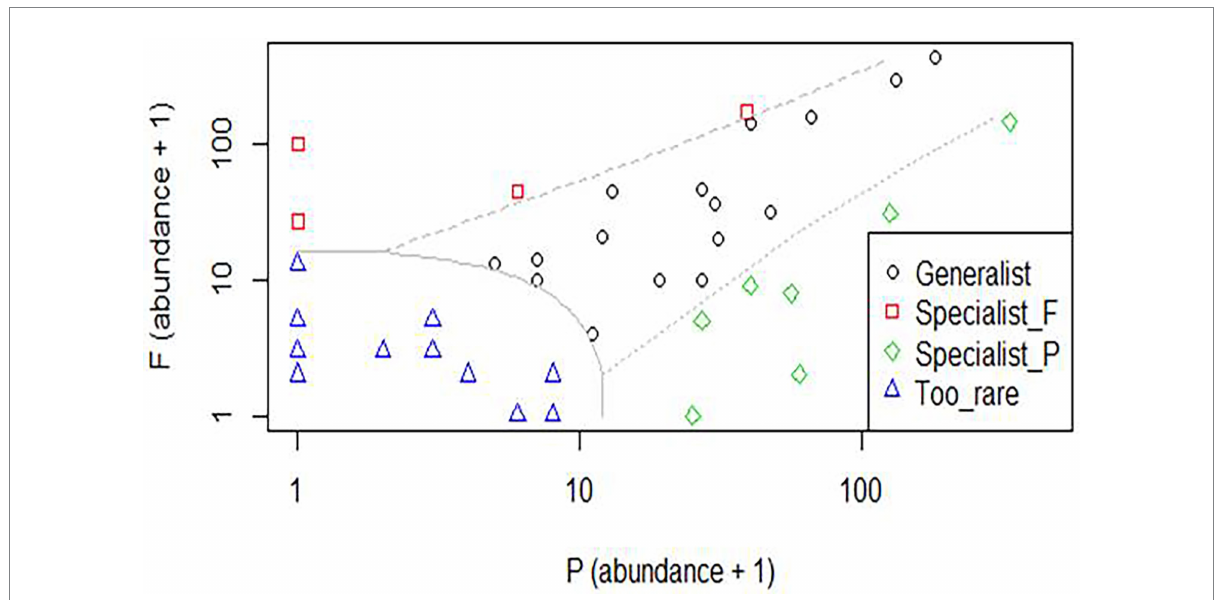
FIGURE 2 Species classification with data collected in habitats of native forest and Pinus monocultures in the State of Santa Catarina, southern Brazil. Specialist_F, native forest specialist; Specialist_P, Pinus monocultures